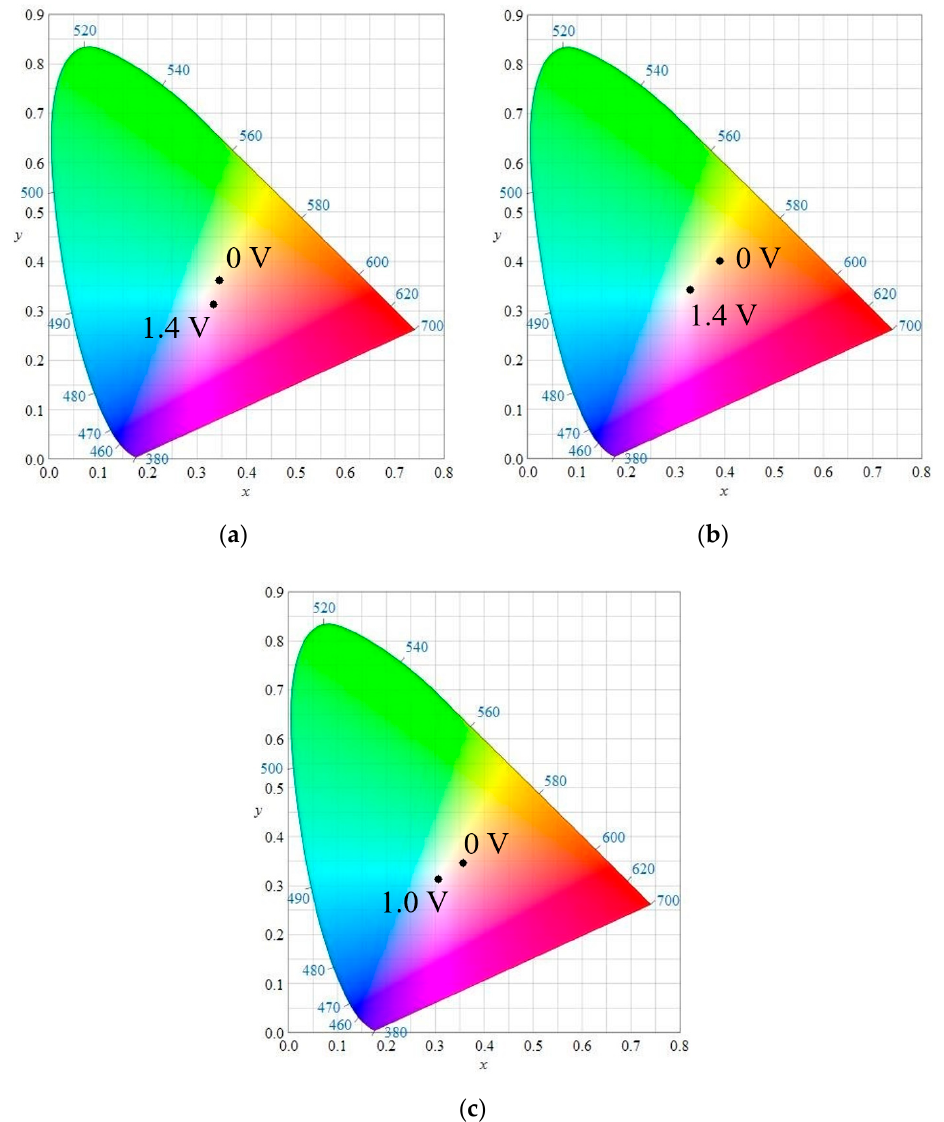
Figure 6. CIE chromaticity charts of: ( a ) PTTPP; ( b ) P(TTPP ‐ co ‐ DTC); and ( c ) P(TTPP ‐ co ‐ DTP) electrodes in [EPI + ][TFSI – ] solution in the oxidized and reduced